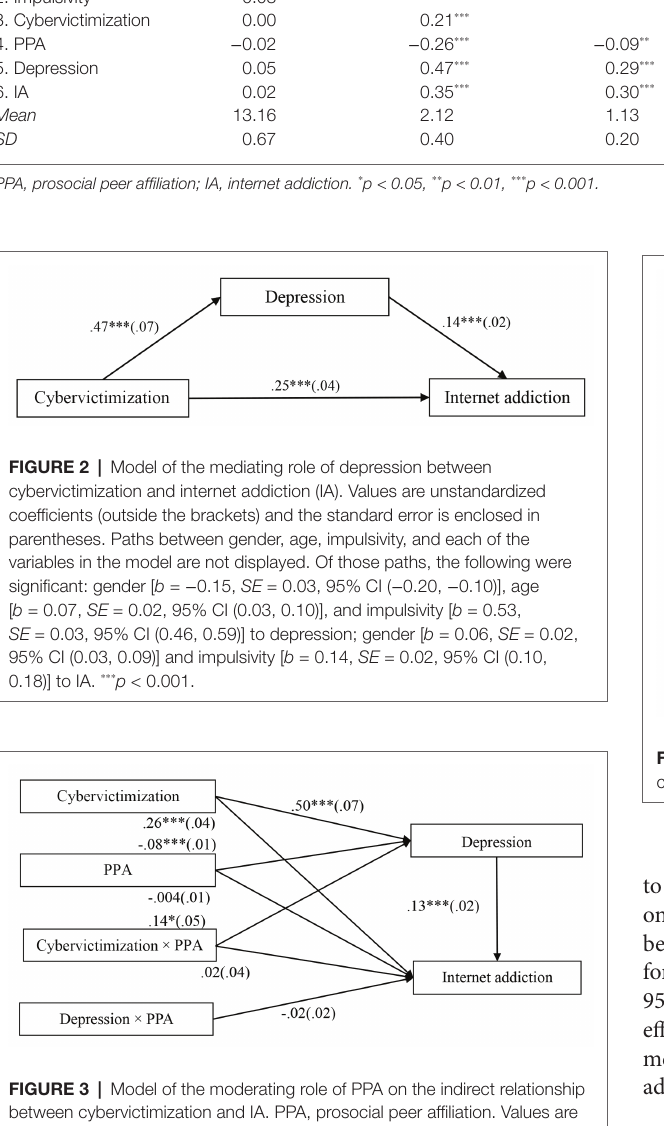
SE = 0.04, 95% CI ( − 0.05, 0.09)] was not significant. Moreover, the interaction between depression and PPA in predicting IA [ b = − 0.02, SE = 0.02, 95% CI ( − 0.05, 0.02)] was also not significant. The explained variance ( R 2 ) is 0.32 for depression and 0.22 for IA.